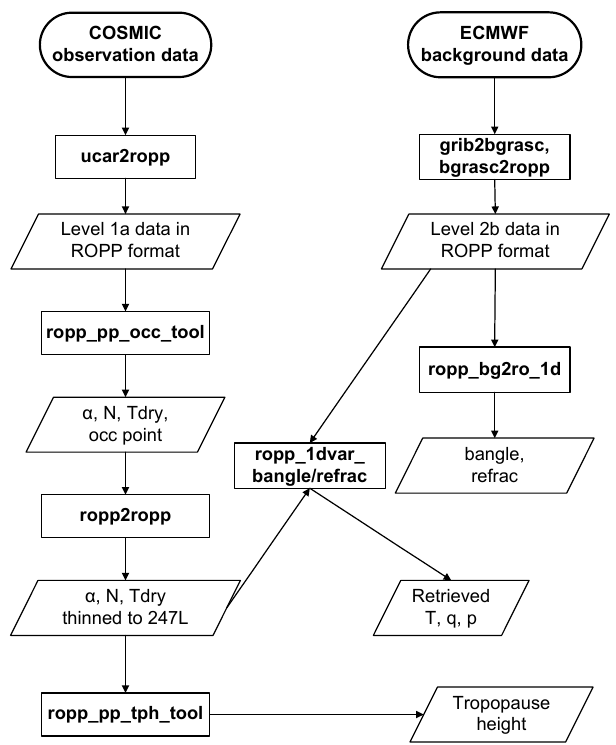
Figure 6. Data flow in the “full chain” of processing described in this paper. Analogous flowcharts would apply if starting from, for example, CHAMP RO data from GFZ and background data from the Met Office NWP model. For brevity, α and “bangle” denote bending angle, while N and “refrac” denote